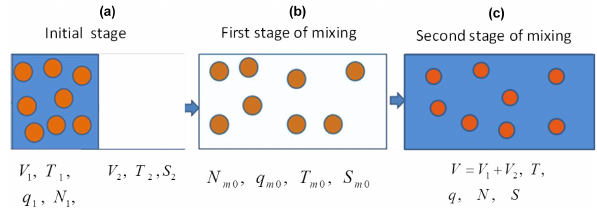
Figure 1. Conceptual scheme of homogeneous mixing in case of monodisperse DSD. The subsaturated volume of dry air is colored white, and the cloudy volumes with saturated air are colored dark blue. The volume forming as a result of mixing after total homoge- nization is colored light blue. Index 1 shows the initial values char- acterizing the initially cloudy volume. Index 2 denotes initial values in the droplet-free volume. Index “m0” denotes values in the mixing volume after the first stage of